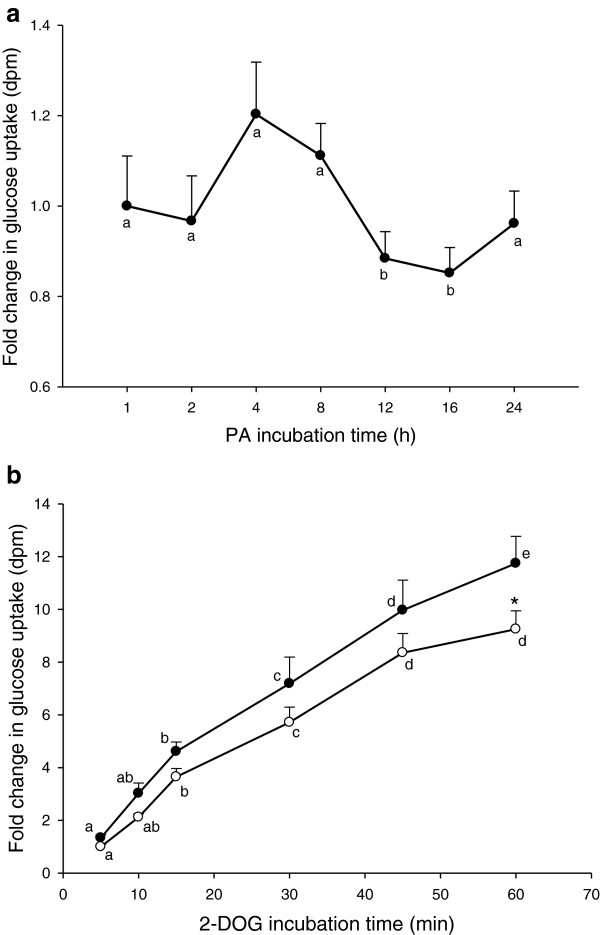
Glucose uptake with or without PA as a function of 2-DOG incubation time. Glucose uptake was performed on differentiated myotubes that had been incubated with (a) 10 μM PA for different times and then treated with 2-DOG for 30 min, or (b) with (full circles) or without (open circles) 10 μM PA for 4 h and afterwards treated with 2-DOG for 5–60 min. Data are expressed as LSmean values of triplicate wells carried out in three separate experiments with cells isolated from a different pig each time. LSmeans with different letters (a-e) denote significantly different responses related to incubation times, while * denotes LSmeans with significantly different responses with or without PA; (P < 0.05).